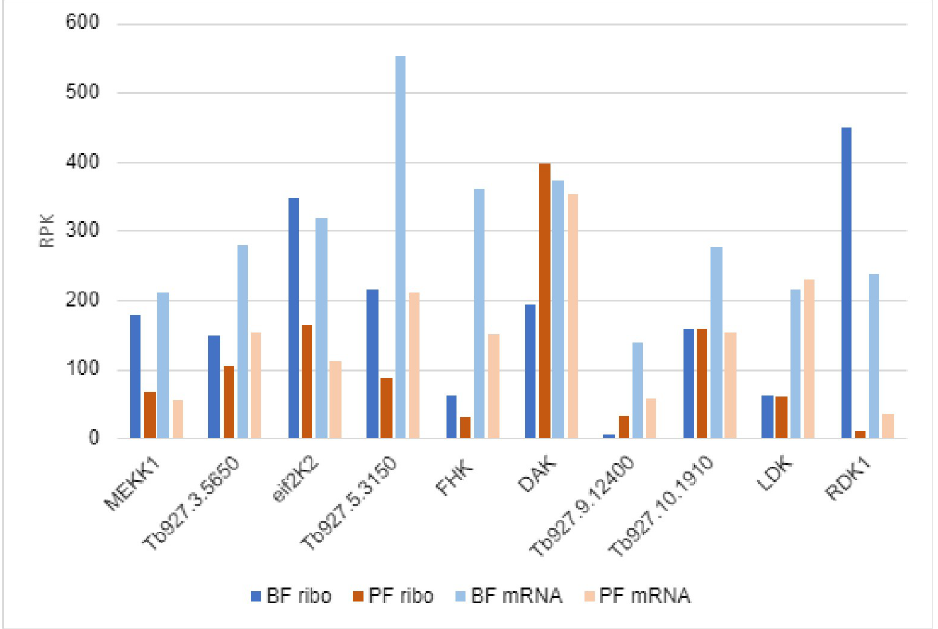
Fig 3. Protein production and mRNA levels of TMD PKs. Protein production was measured by ribosome profiling and mRNA levels were measured in the same biological samples (three replicates each). Data is shown as reads per kb and is derived from